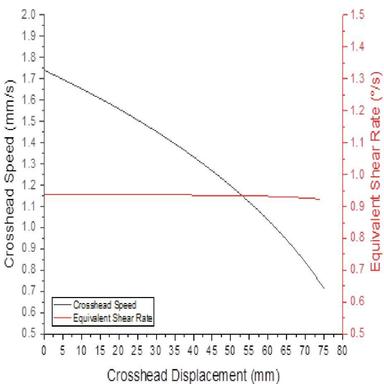
BE test results of CEP-TW1 at different temperatures and shear rates.